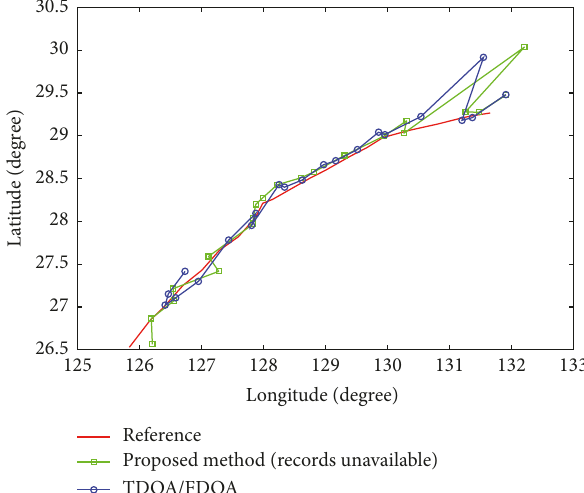
Figure 6: Examples of estimated vessel positions for records unavailability